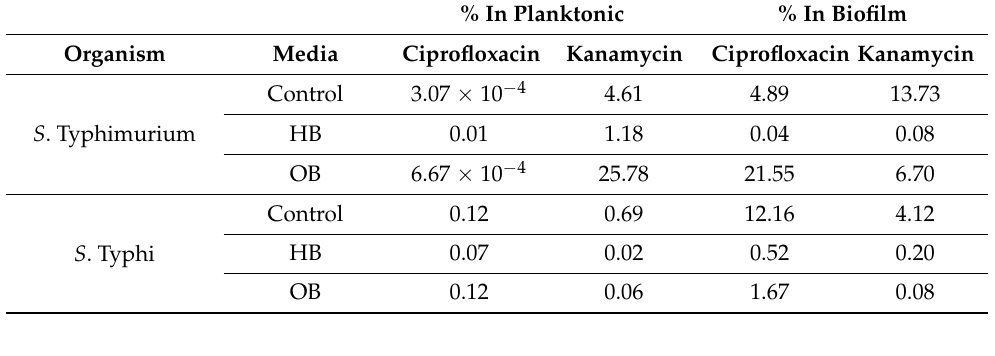
Table 1. Percentage of persister cells recovered after anti-microbial treatment in different growth conditions.